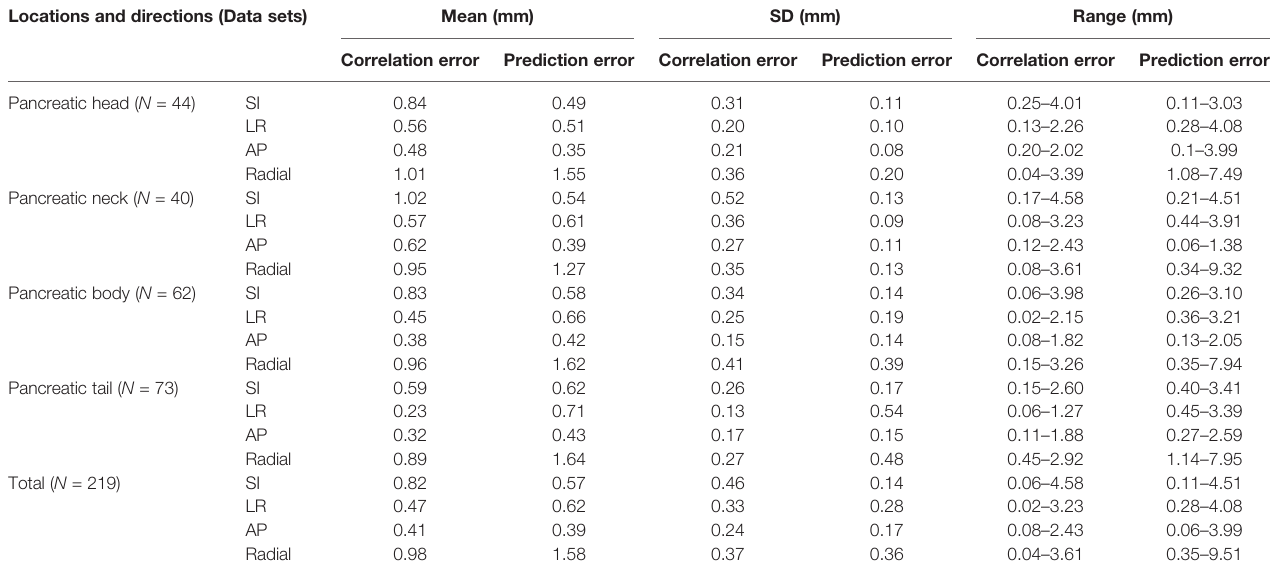
TABLE 2 | Summary of the correlation and prediction errors in 219 fractions. Locations and directions (Data